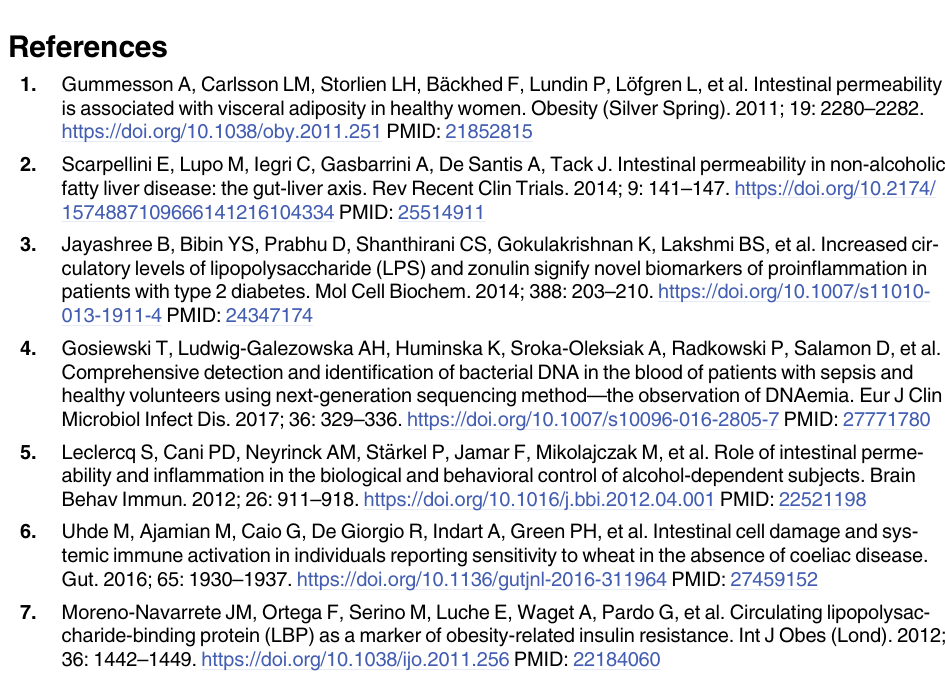
S1 Table. Anonymized data set. S2 Table. Metabolic characteristics and LGM levels separately for sex. S3 Table. Metabolic characteristics and LGM levels separately for age ( < 54 years and � 54